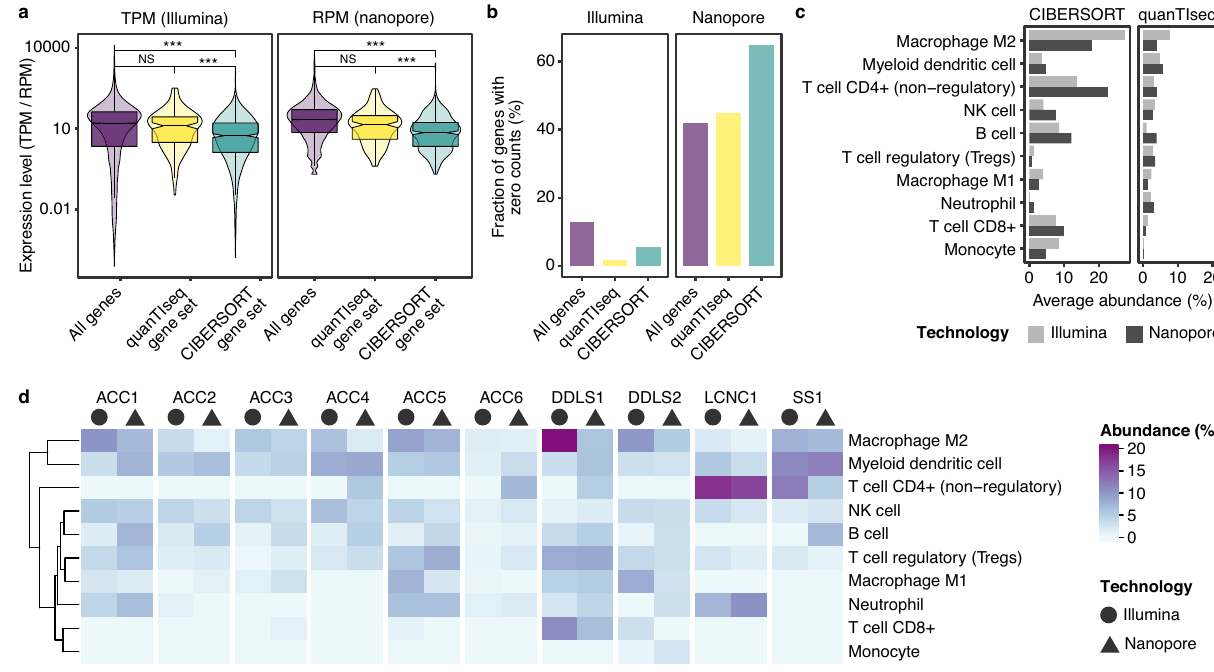
Figure 3. Estimation of immune cell abundance from shallow nanopore and Illumina RNA-seq data. ( a ) Expression levels, determined by Illumina (as TPM) and nanopore RNA-seq (as RPM), of all protein-coding genes and gene sets used in quanTIseq (n = 170) and CIBERSORT (n = 547). Groups were compared using two- sided Welch’s t-test. ***, p < 0.001; NS, not significant. ( b ) Number of genes with zero counts in more than 50% of samples, as determined by Illumina and nanopore RNA-seq, of all protein-coding genes and gene sets used in quanTIseq and CIBERSORT. ( c ) Estimated average abundance of immune cell fractions based on Illumina and shallow nanopore RNA-seq data as a function of the deconvolution method used. ( d ) Immune cell abundance of the ten tumor samples calculated with quanTIseq based on Illumina and nanopore RNA-seq